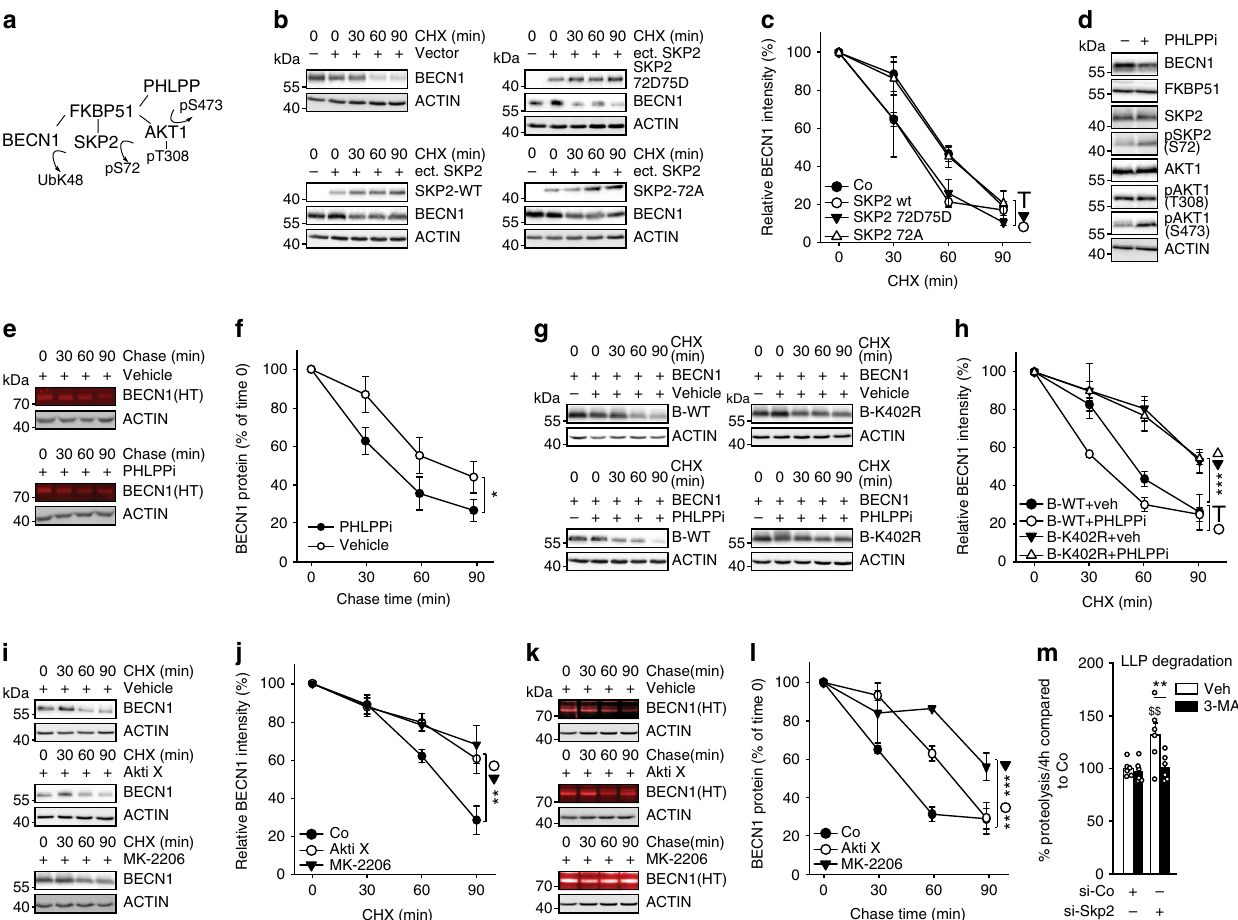
Fig. 4 SKP2 is controlled by AKT-PHLPP mediated phosphorylation involving FKBP51. a Model of FKBP51`s kinase associations that regulate SKP2